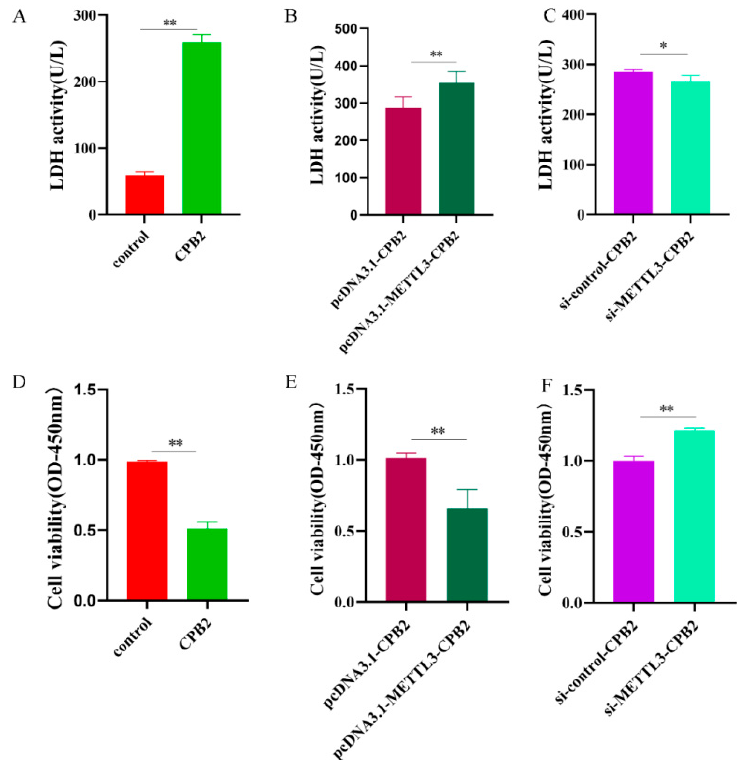
Figure 4. The impacts of METTL3 overexpression or knockdown on cytotoxicity and cell survival in CPB2-exposed IPEC-J2 cells. ( A – C ) The activity of LDH in IPEC-J2 cells and the results represent the absorbance at 450 nm. ( D – F ) IPEC-J2 cell viability as measured by the CCK-8 test. All data are based on three separate trials and presented as mean ± SD. ** p < 0.01 and * p < 0.05, respectively.